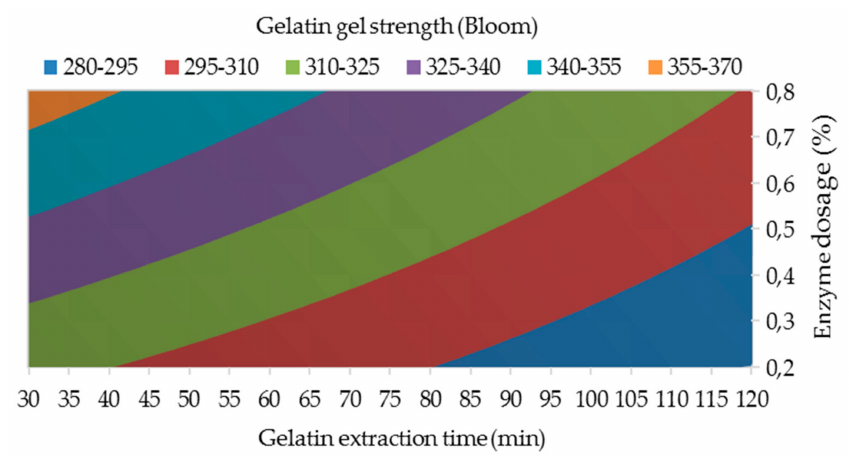
Figure 2. The influence of enzyme dosage and gelatin extraction time (at 48 h of enzyme processing time) on the gelatin gel strength.